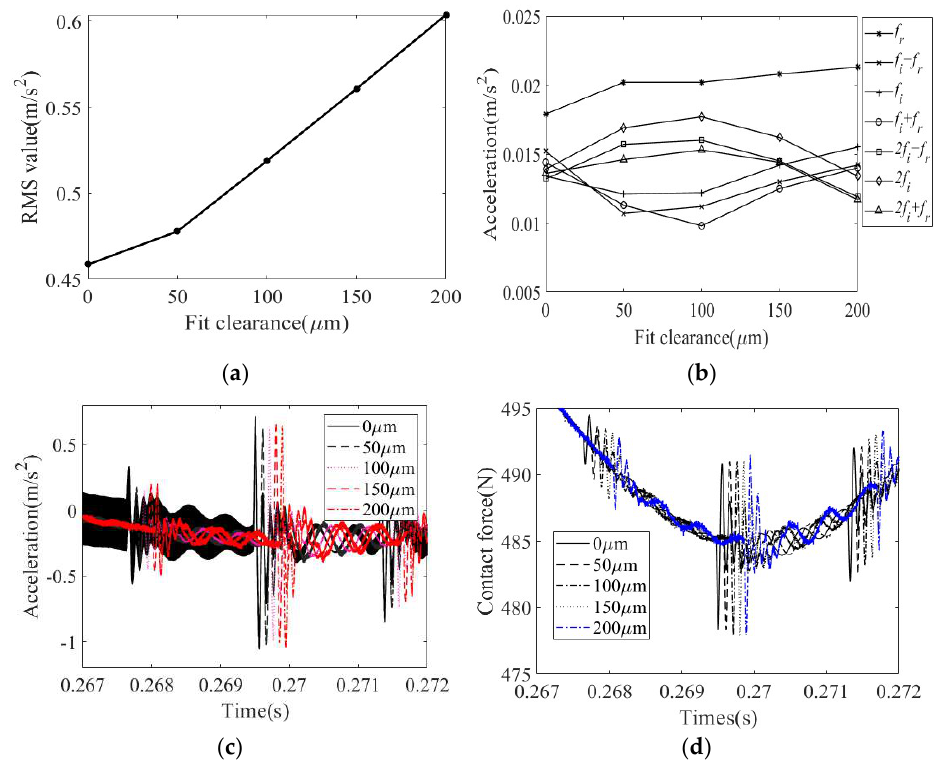
Figure 11. The vibration characteristics of the bearing under inner ring defect and fit clearance: ( a ) RMS; ( b ) amplitudes of f r , f i − f r , f i , f i + f r , 2 f i − f r , 2 f i , 2 f i + f r ; ( c ) housing acceleration signal from 0.267 s to 0.272 s; ( d ) contact force between outer ring and housing from 0.267 s to 0.272 s.